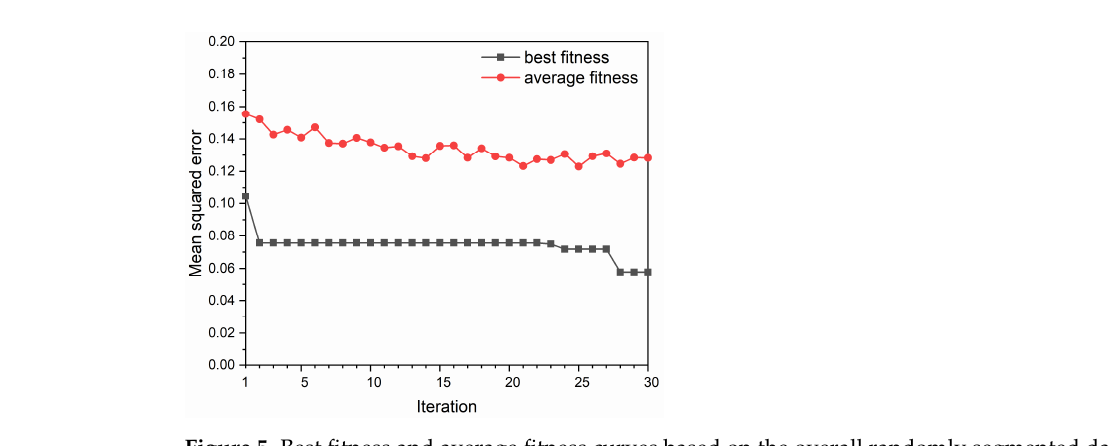
Figure 7. The specific data distribution of the training set and test set based on the overall randomly segmented dataset. 3.2.2. Categorized Randomly Segmented Dataset The P&S model was aimed to predict the UCS value of different tailings. Since the dataset was composed of three different types of tailings experimental data, the whole dataset was first segmented into three subsets according to the classification of the tailings. Then each of the subsets was segmented into two subsets with a size ratio of 8:2 randomly to be the training set and test set. Figure 8 shows the details of the training set and test set based on the categorized randomly segmented dataset. It can be seen that the data of the training set and the test set achieved a uniform distribution in each type of tailings.